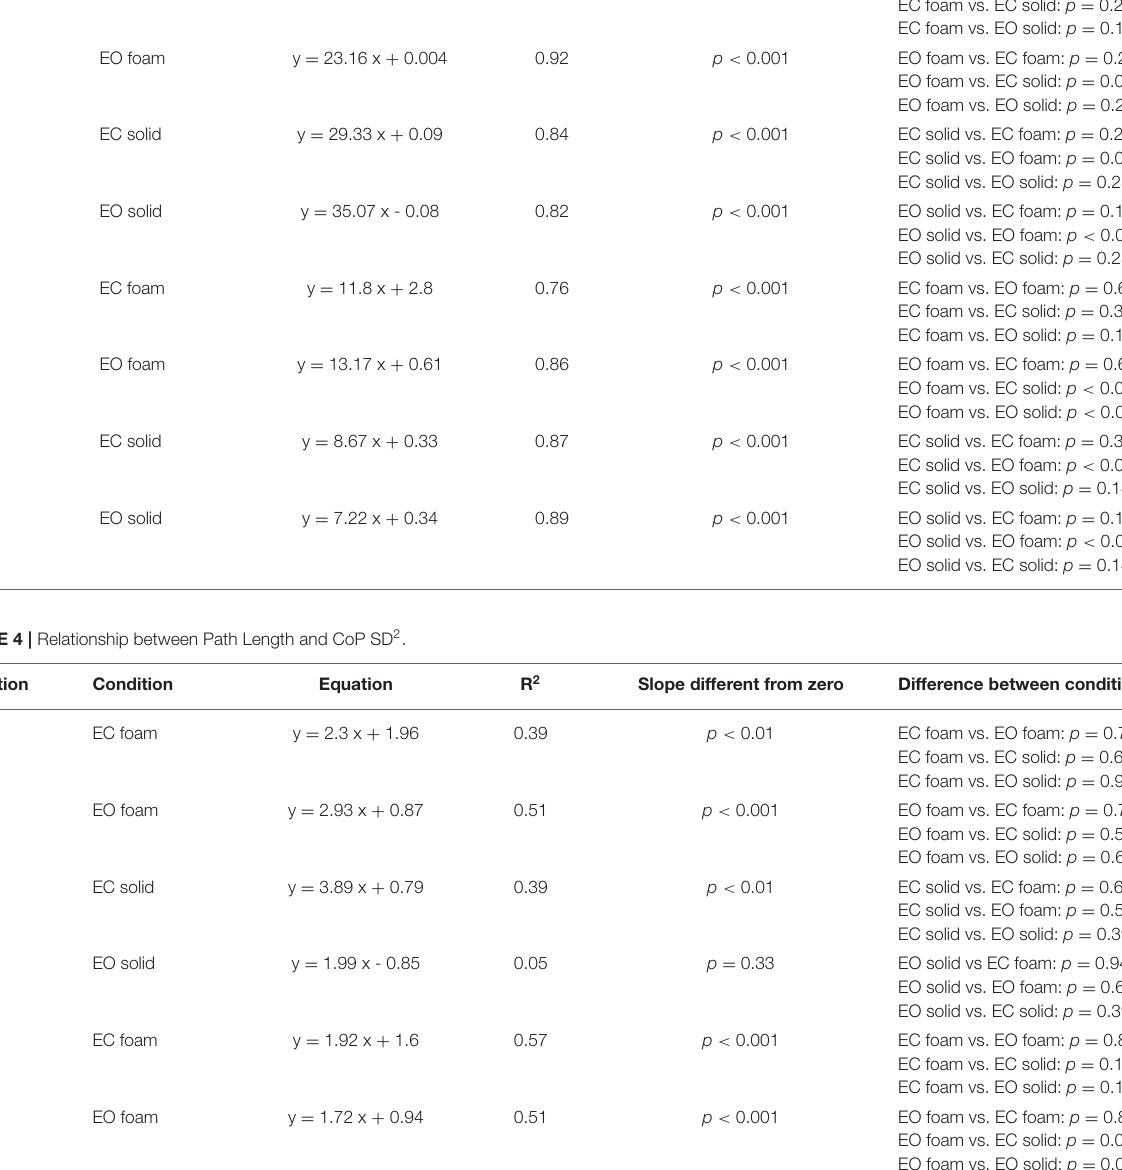
TABLE 3 | Relationship between Sway Area and CoP SD 2 . Direction